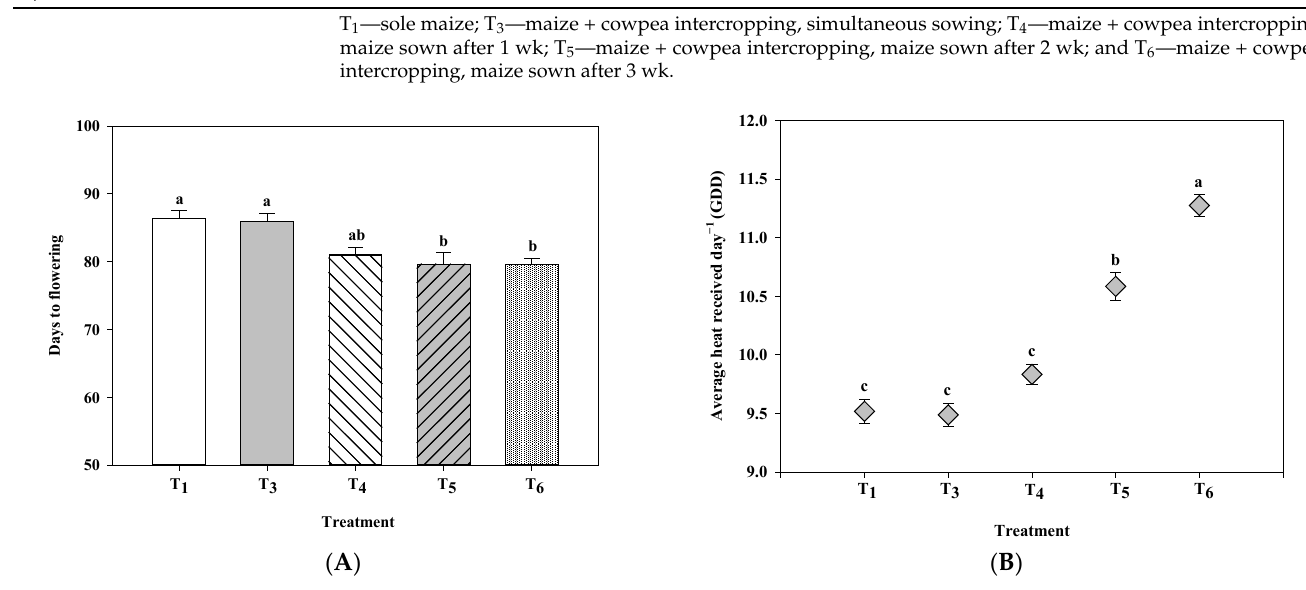
Figure 1. Days to flowering (panel ( A )) and average thermal units (growing degree days) per day received during vegetative stage of maize (panel ( B )) grown under the different sole and intercropping treatments. The treatments are: T 1 —sole maize; T 3 —maize + cowpea intercropping, simultaneous sowing; T 4 —maize + cowpea intercropping, maize sown after 1 wk; T 5 —maize + cowpea intercrop- ping, maize sown after 2 wks; and T 6 —maize + cowpea intercropping, maize sown after 3 wks. Different letters above the bars indicate statistically significant differences at Tukey’s HSD (a = 5%). Error bars represent the standard error of means, N = Table 2. Yield and yield contributing characters of maize grown under different treatments (means ± SE, N = 3).